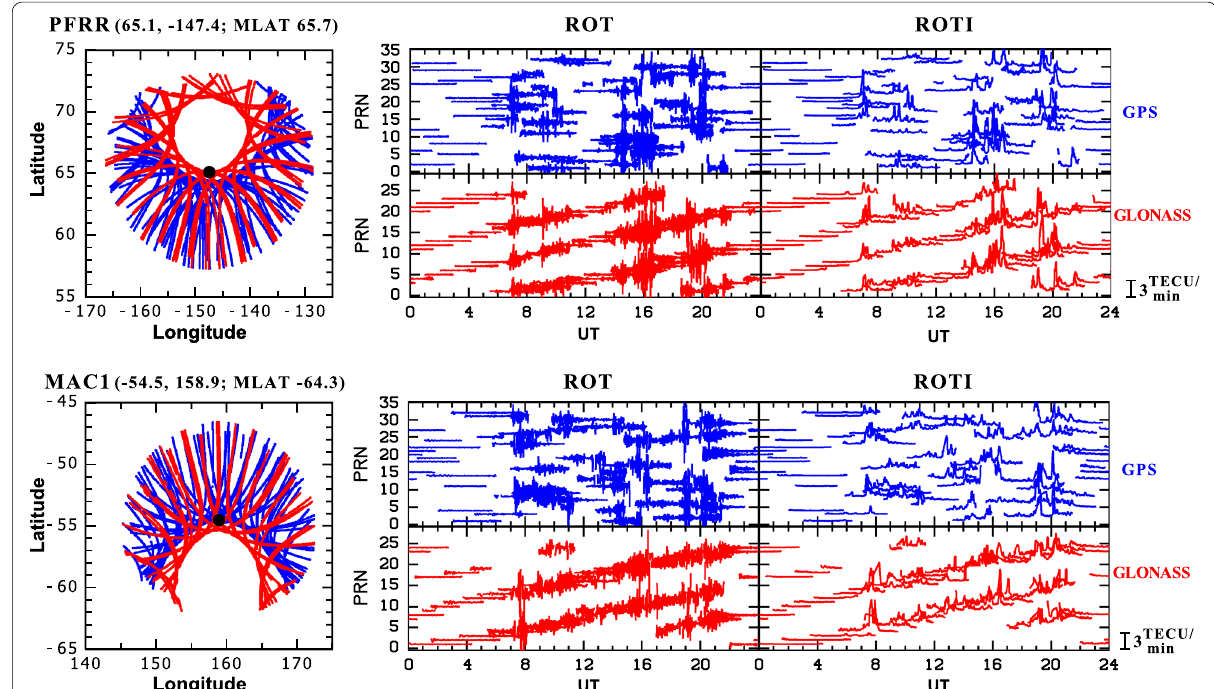
Fig. 3 Examples of GPS and GLONASS measurements for two ground-based stations PFRR (65.1°N; 147.4°W) and MAC1 (54.5°S; 158.9°E) on the dis- turbed day of June 22, 2015: the distribution of IPP projections over a single station ( left panel ) with a black dot indicating the location of the station; the derived ROT variation ( middle panel ) and ROTI variation ( right panel ) along all visible satellites. GPS measurements are shown as blue, GLONASS measurements as red , while the left axis shows the satellite number